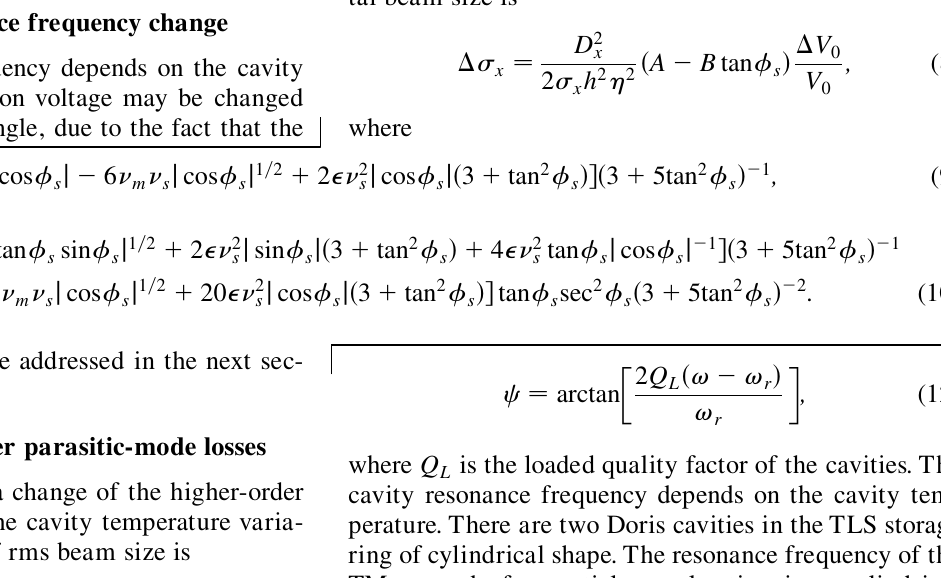
(cid:3) 24 : 929 kHz , f (cid:3) s m